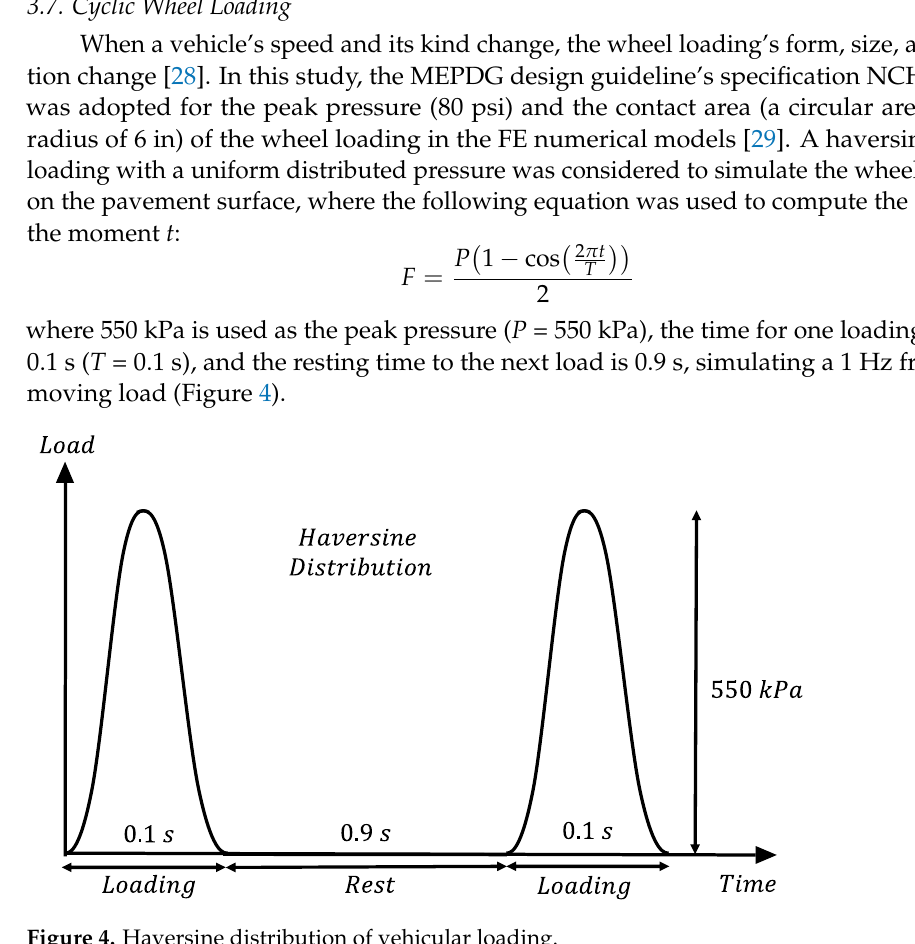
Table 5. Maximum lateral confining stress for geosynthetics with varying levels of stiffness.